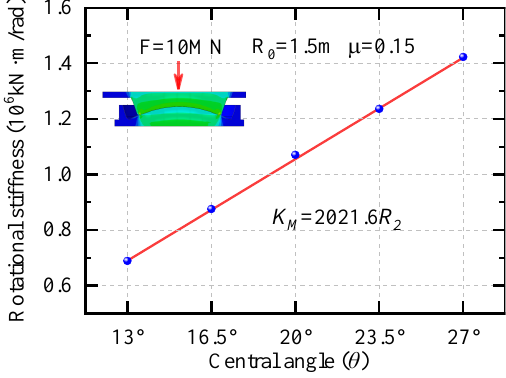
Figure 10. Related curve of the RCS-central angle.